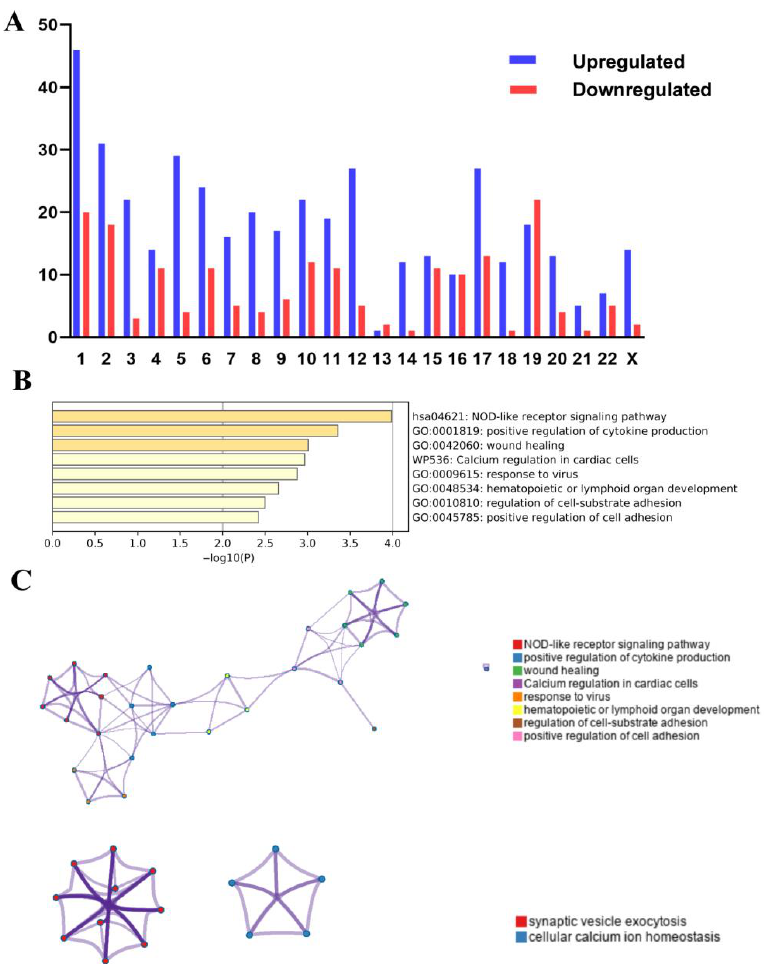
Figure 5. Location of differentially expressed genes and their functional analysis. ( A ): The enrichment of chromosomes using 419 upregulated DEGs and 182 downregulated DEGs in aneuploid cell lines. ( B ): Enrichment using the 46 upregulated DEGs on chromosome 1. ( C ): Enrichment using the 46 upregulated DEGs on chromosome 1 ( left ) and the 22 downregulated DEGs on chromosome 19 ( right ).